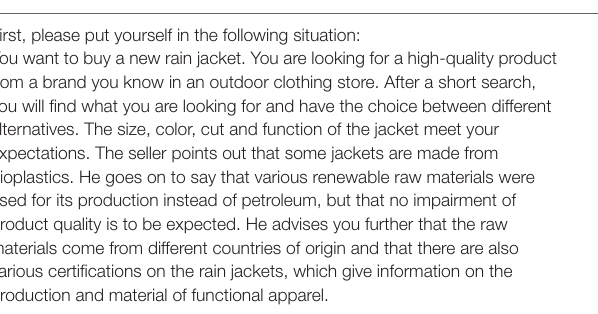
TABLE A1 | CBC introductory text.